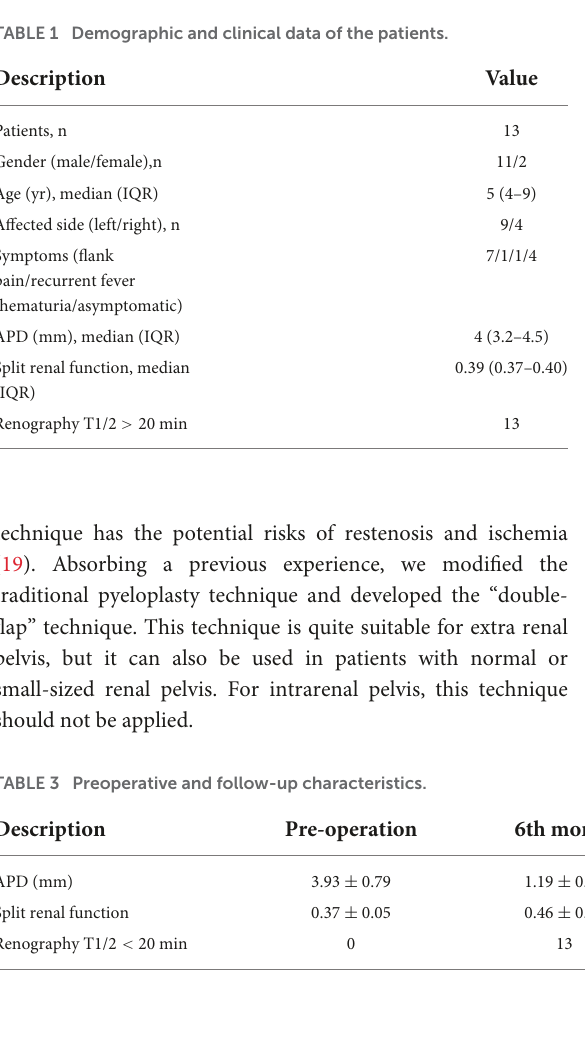
FIGURE4 The “double-flap” technique. (A) Cut by line. (B) Pelvis double flaps. (C) Spatulate longitudinally along the lateral edge of the ureter. (D) Continuous posterior wall anastomosis. (E) Continuous anterior wall anastomosis. (F) Continuous superior flap anastomosis.